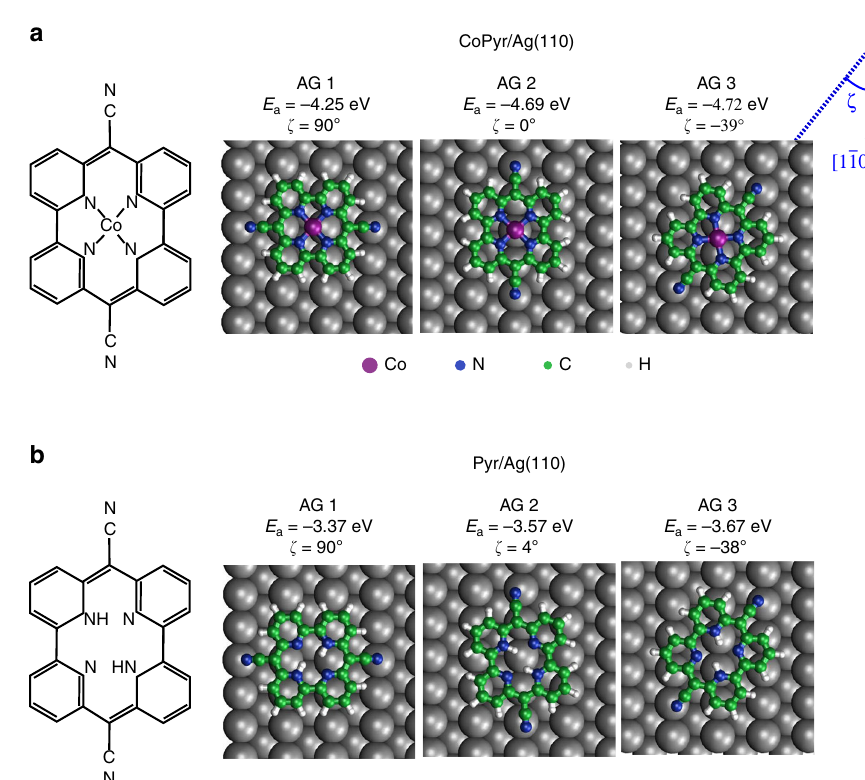
) on the Ag(110) surface. a Co-pyrphyrin (CoPyr) on Ag(110). b Pyrphyrin a